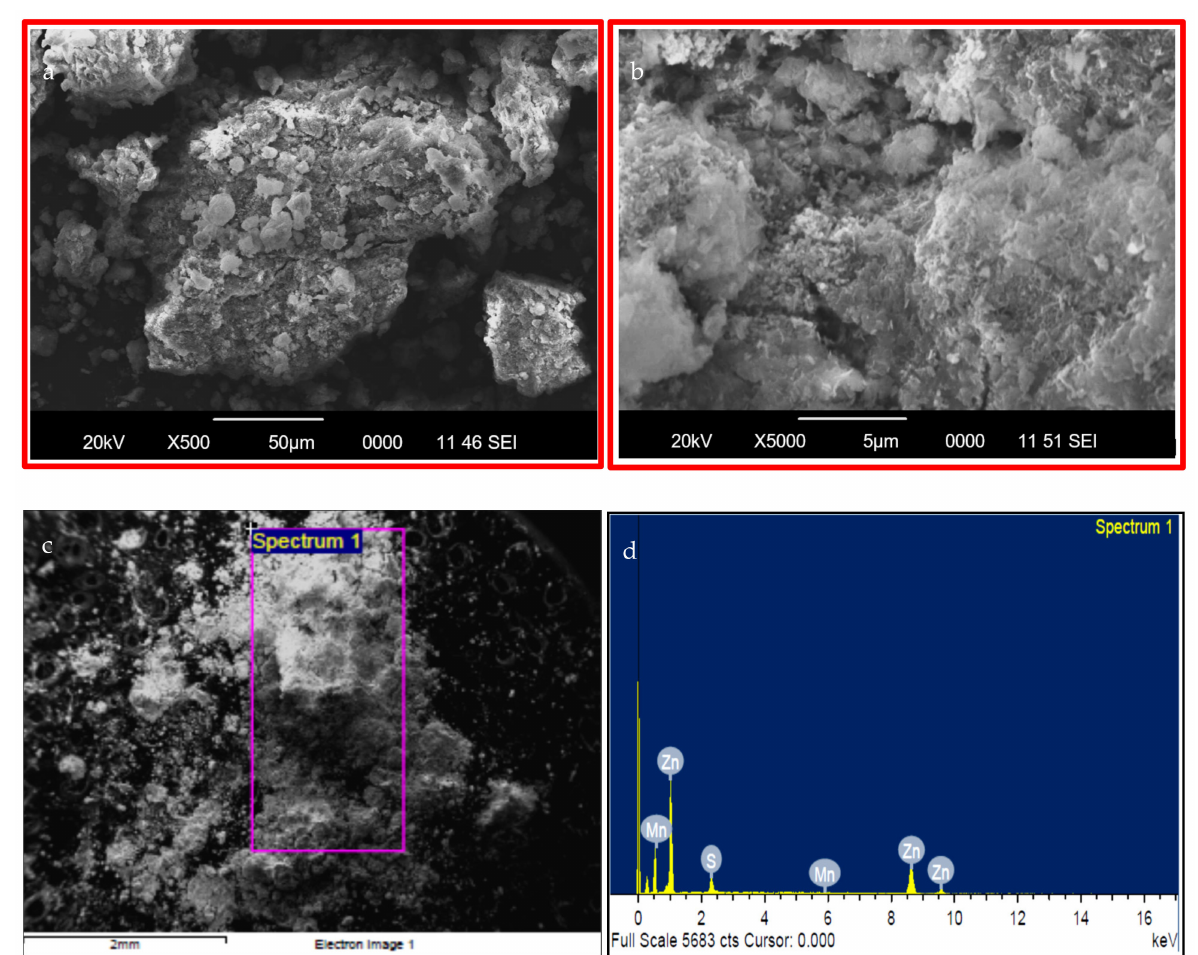
Figure 2. ( a – c ) SEM images of Mn 2+ :ZnS Qds; ( d ) EDX spectra of the marked area (spectrum